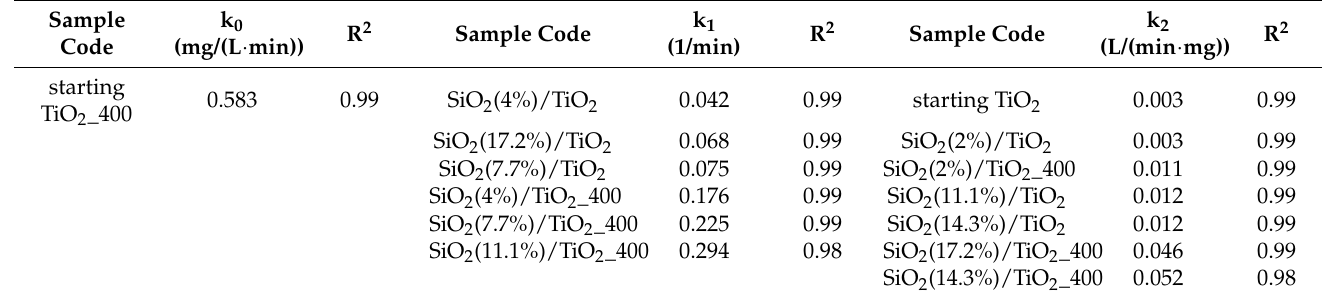
Table 3 . The fitting parameters, zero, pseudo-first, and pseudo-second reaction rate constants for methylene blue decomposition (after 5 h of UV radiation).